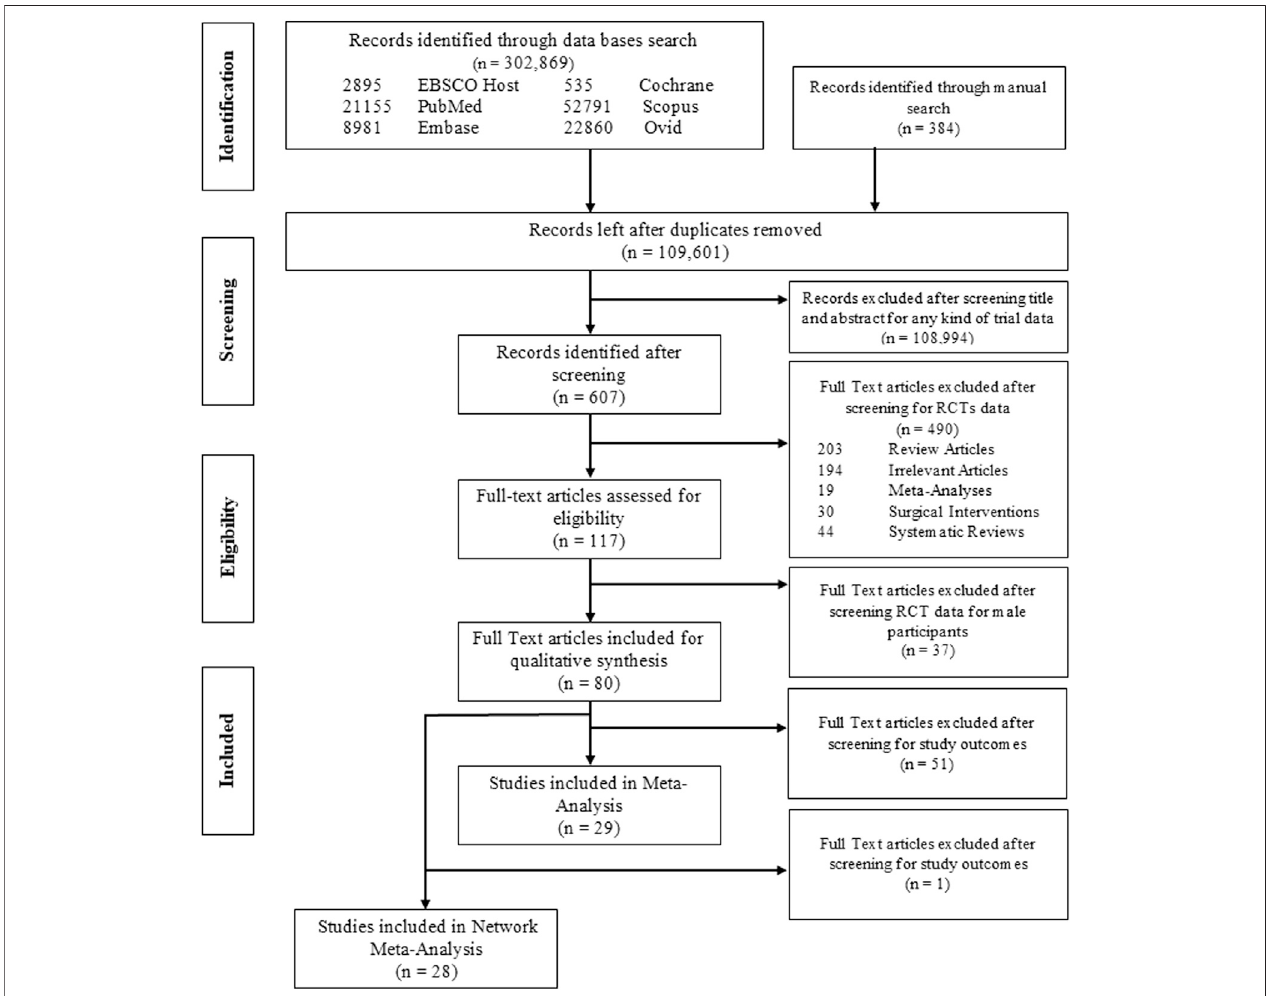
FIGURE 1 | Prisma fl ow